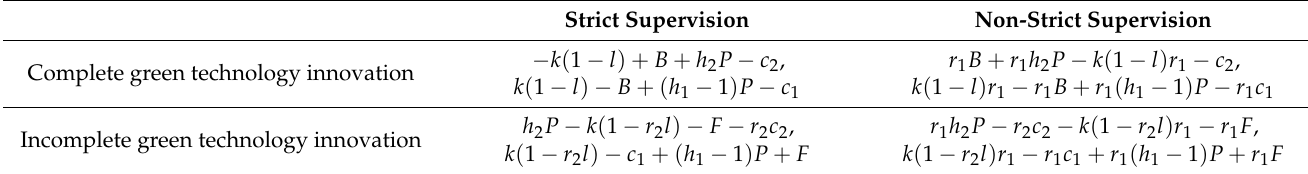
Table 1. Payment matrix of the game between the local government and the enterprise. Strict Supervision Non-Strict Supervision Complete green technology